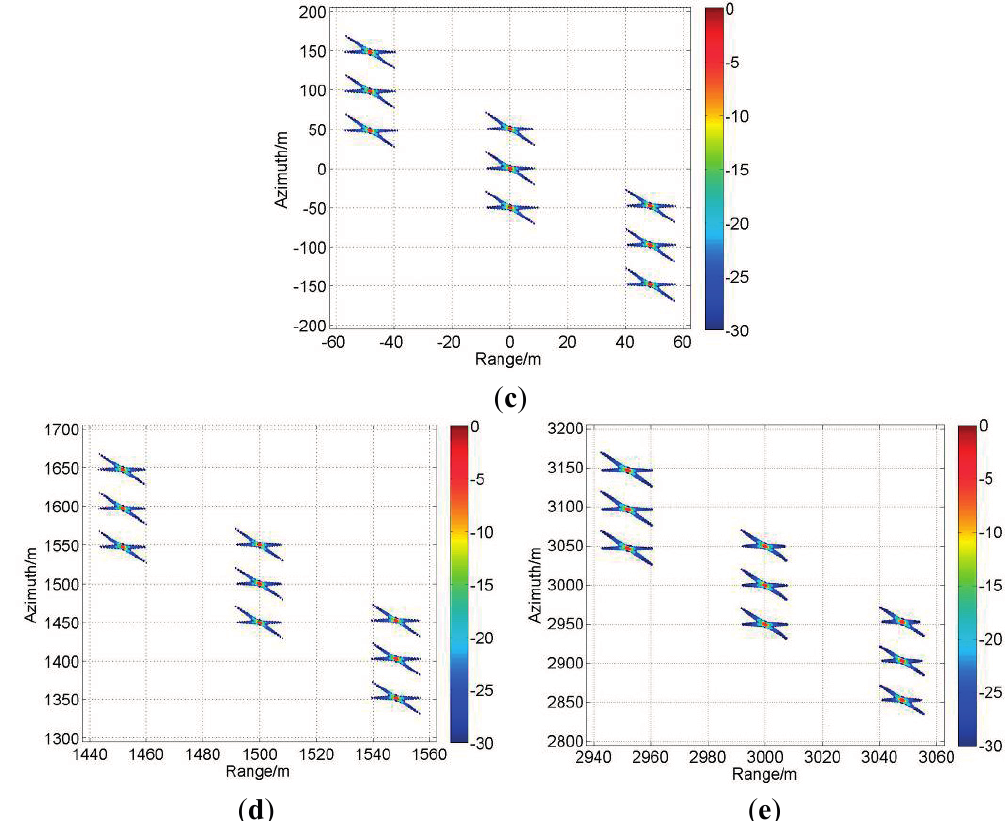
Figure 10. Imaging results for the five different regions. ( a ) Imaging results of A-region; ( b ) Imaging results of B-region; ( c ) Imaging results of C-region; ( d ) Imaging results of D-region; ( e ) Imaging results of